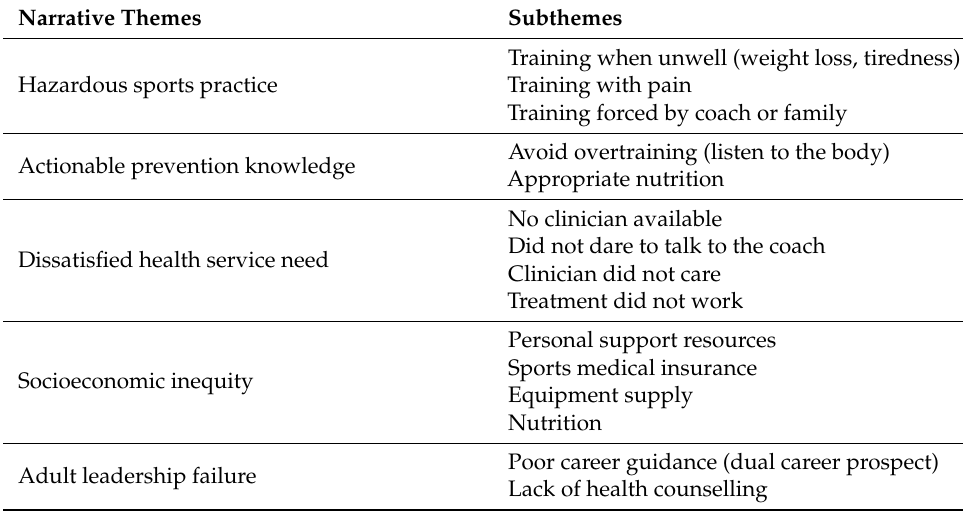
Table 2. Narrative